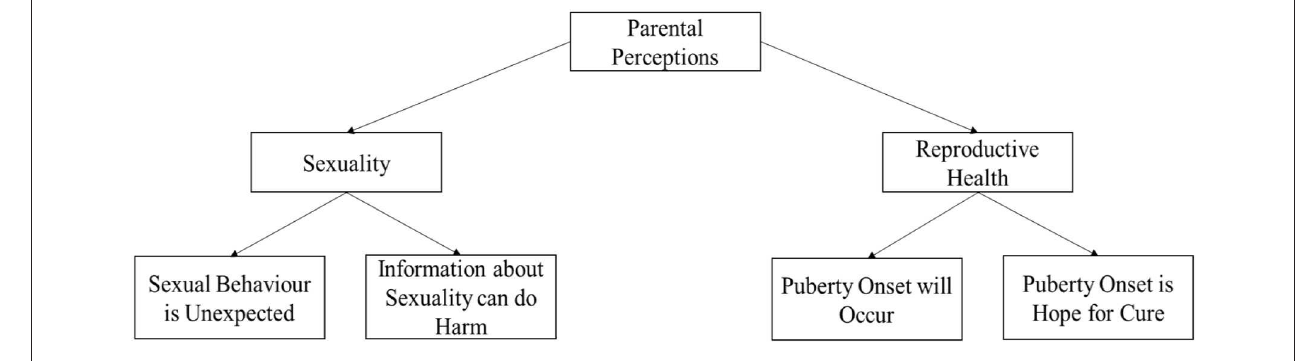
FIGURE 1 | Parental perceptions.